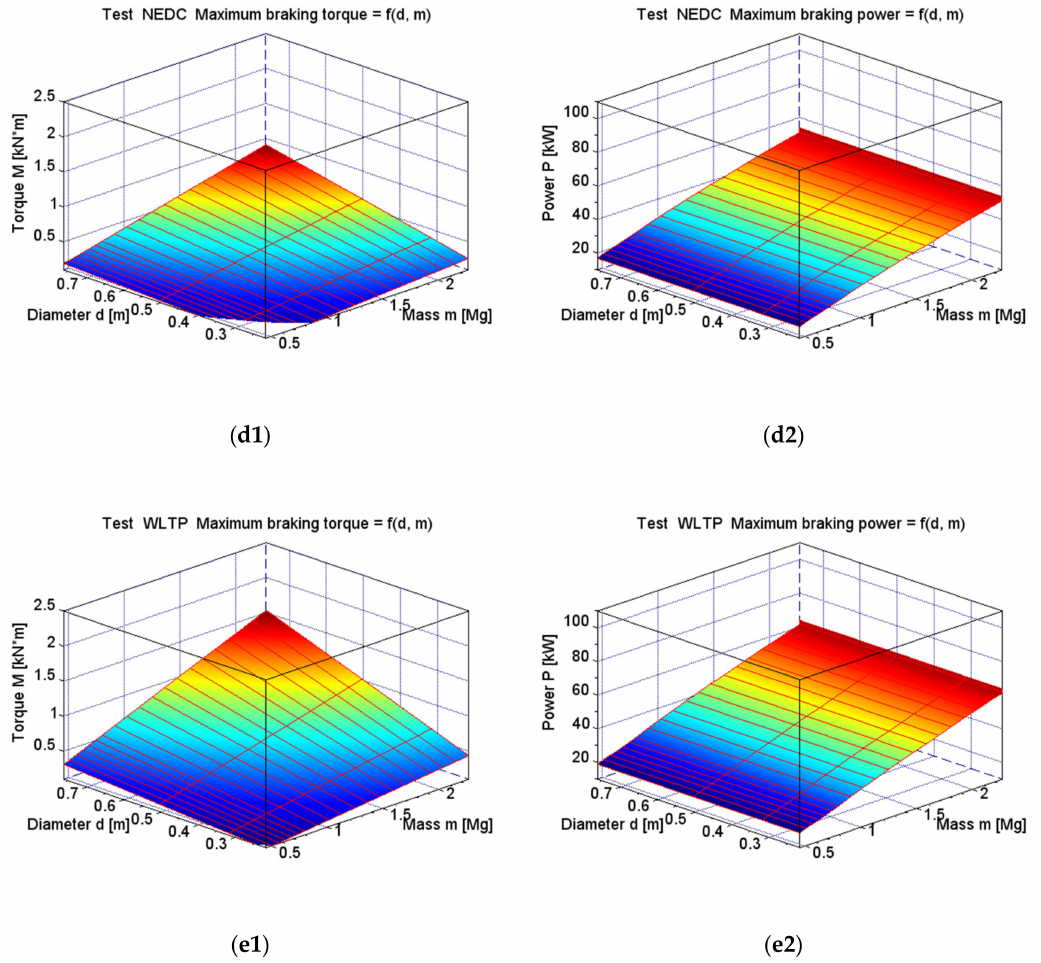
Figure 4. Simulation results for the test in waveforms as a function of the vehicle weight and brake roller diameter: CADCM150: ( a1 ) maximum braking torque; ( a2 ) maximum braking power; CADC150: ( b1 ) maximum braking torque; ( b2 ) maximum braking power; FTP75: ( c1 ) maximum braking torque; ( c2 ) maximum braking power; NEDC: ( d1 ) maximum braking torque; ( d2 ) maximum braking power; WLTP: ( e1 ) maximum braking torque; ( e2 ) maximum braking